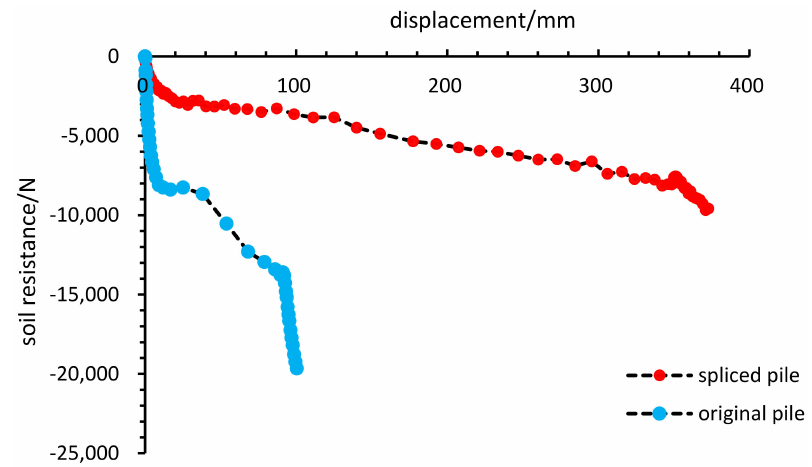
Figure 6. Soil resistance analysis of pile–soil internal